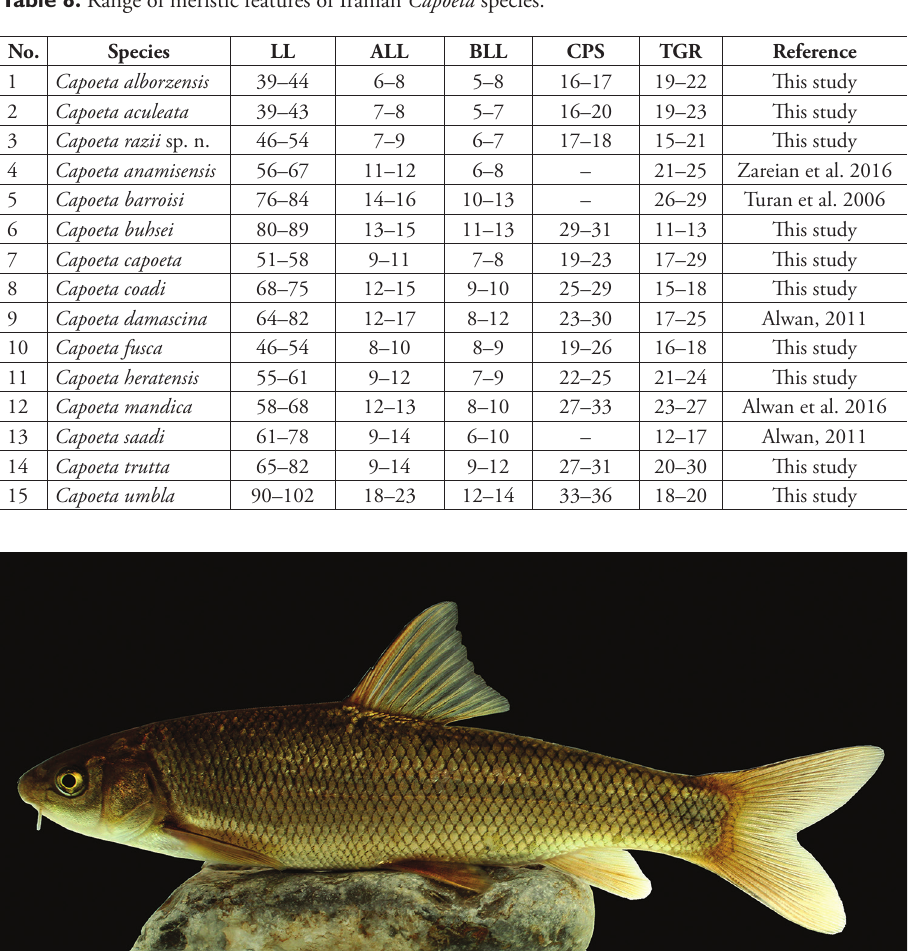
Figure 9. Uncatalogued live specimen of Capoeta capoeta . Iran: Ajab Shir town, Ghale Chay River, Urmia